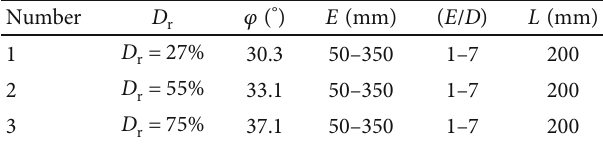
Table 2: Parameters of the test program.